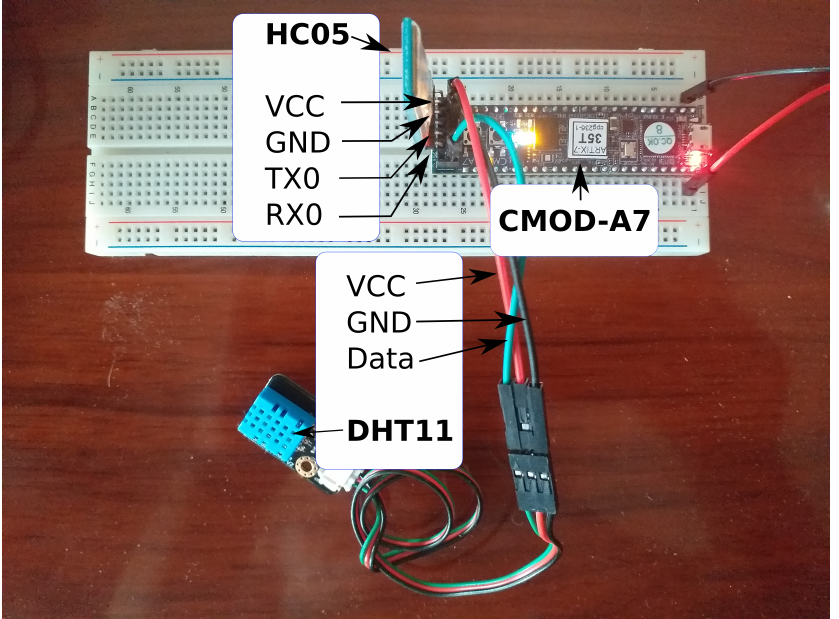
Figure 11. Experimental setup for minimal Dracon extended with Bluetooth connectivity and measurements with a DHT11